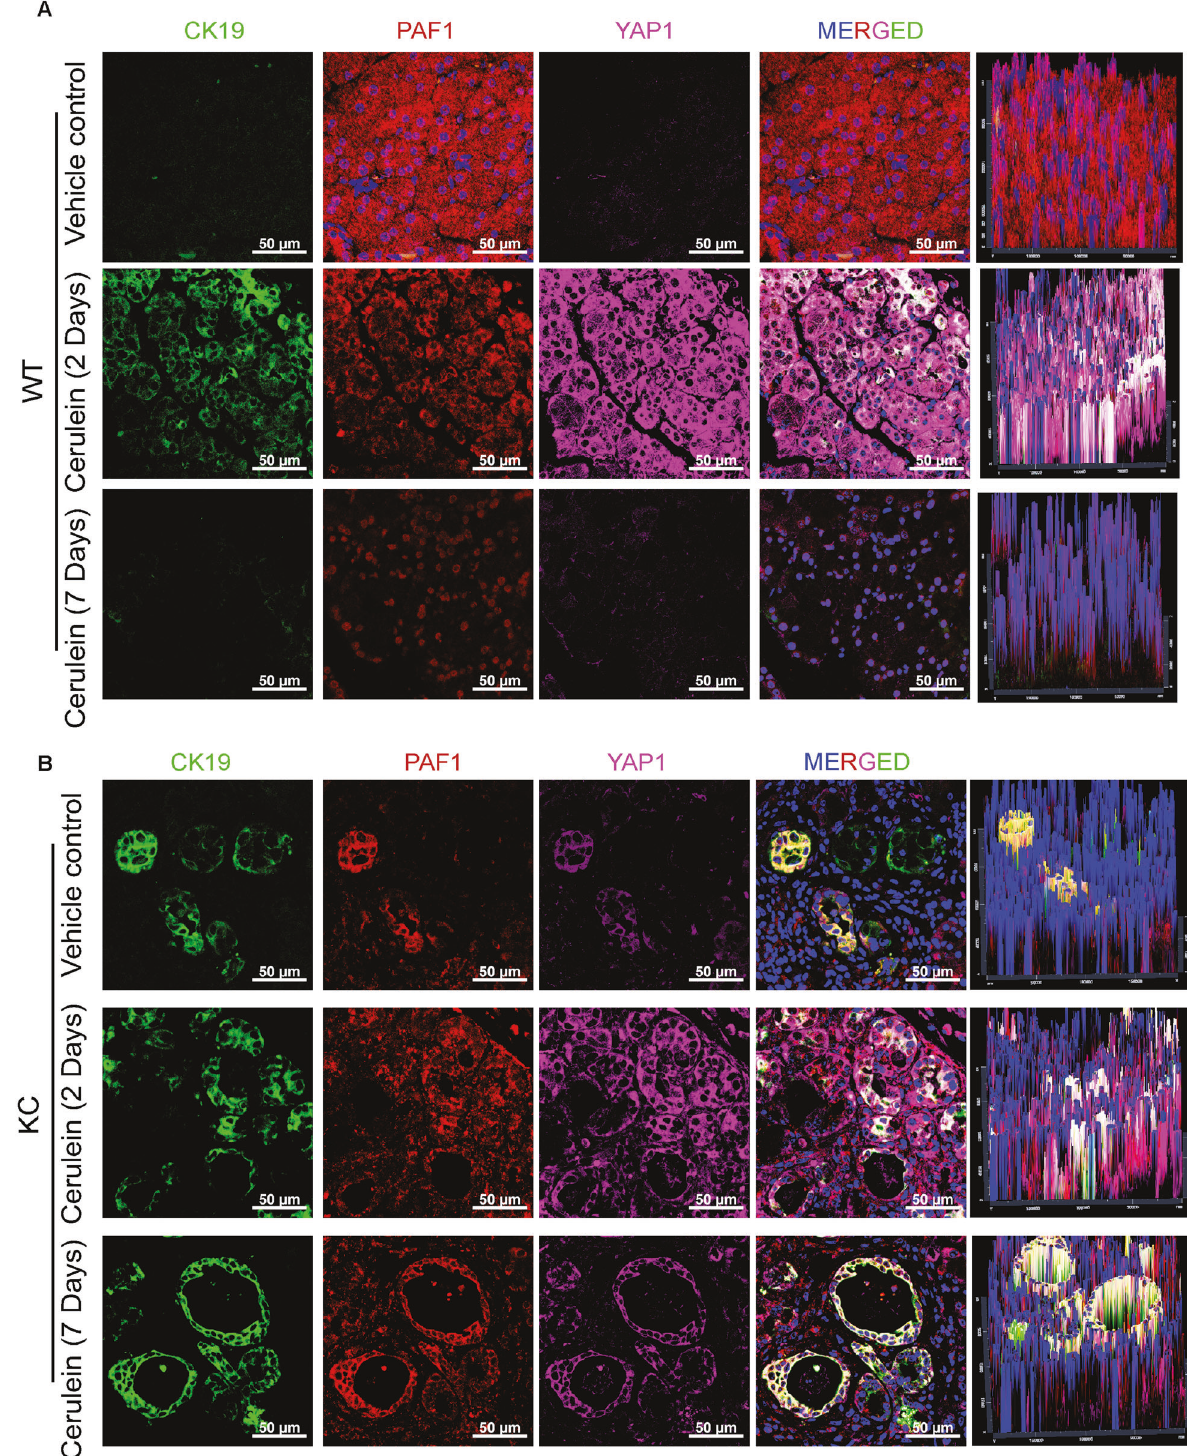
Fig. 2 Co-expression of PAF1 with YAP1 in the pancreas tissues of cerulein-induced wild-type (WT) and Kras G12D ; Pdx-1 Cre (KC) acute pancreatitis mouse models. A , B Immuno fl uorescence images of pancreas harvested from cerulein-treated WT and KC mice stained with PAF1, YAP1, and CK19. Pancreas tissues were harvested from WT and KC mice after 2 and 7 days of the last cerulein injection. Scale bar 50 µm.